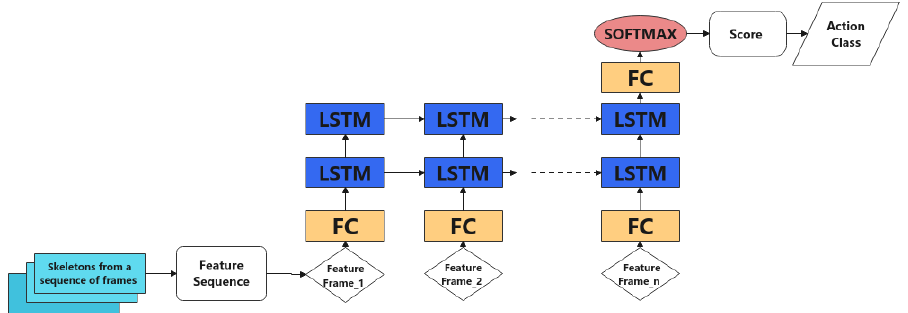
Figure 5. The base model was used as the baseline for evaluating the performance of action recogni- tion on various feature